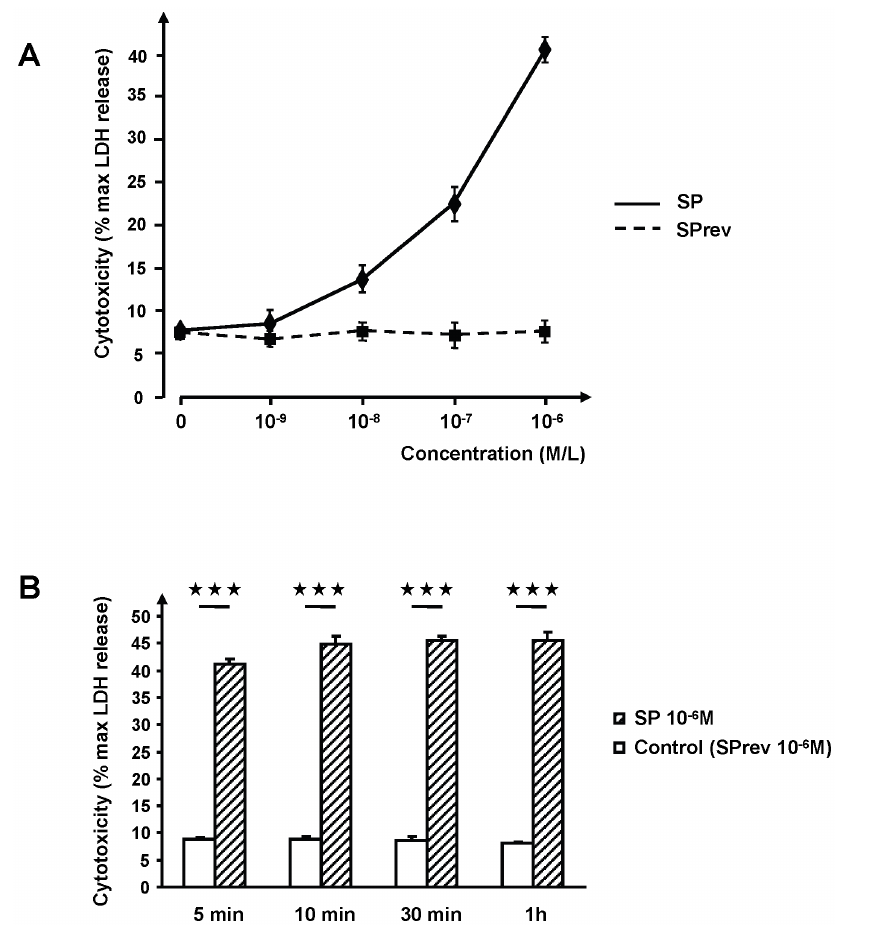
Figure 1. Effect of Substance P on the cytotoxic activity of Bacilluscereus . ( A ) Dose response curve of the effect of Substance P (SP) and of the reversed sequence peptide (SPrev). ( B ) Time course response of the bacteria to SP and SPrev (10 2 6 M). ( www =p , 0.001).